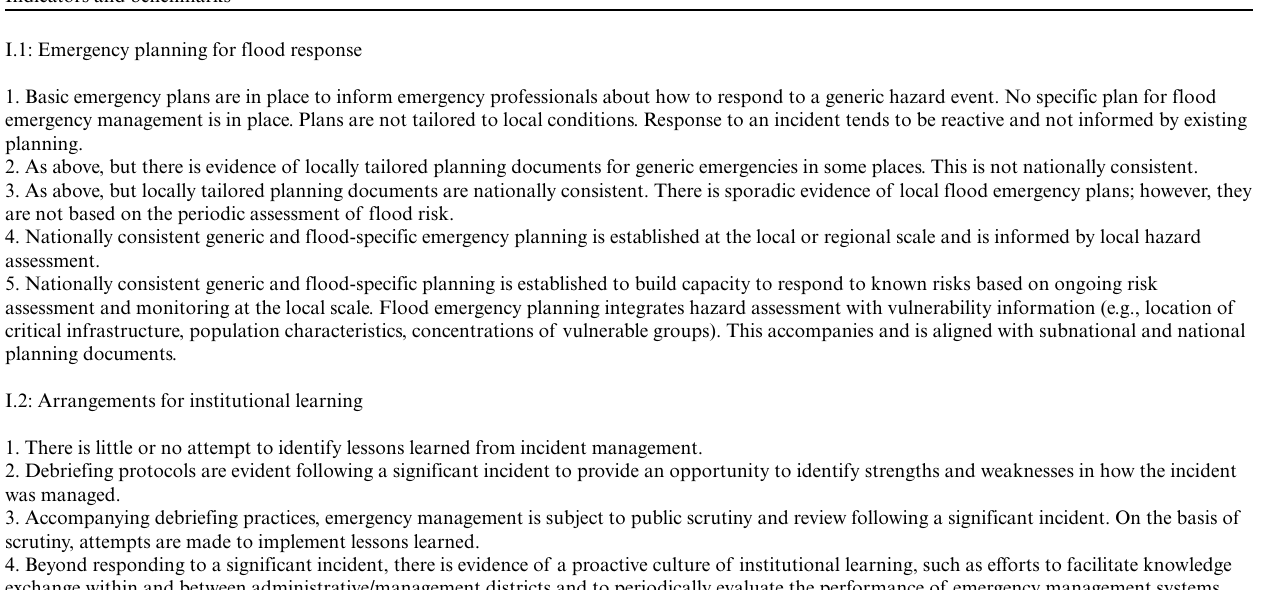
Table 1. Indicators (I) and benchmarks of effective Flood Emergency Management Systems. (Benchmarks are scaled as